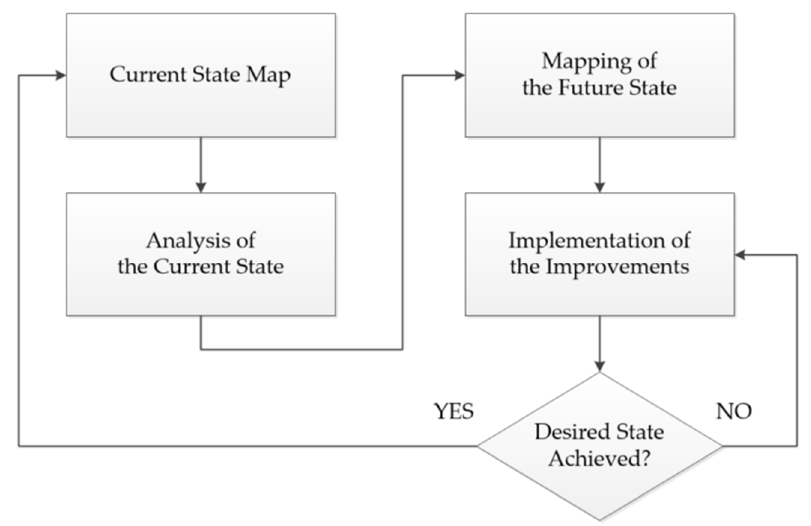
Figure 1. Value Stream Mapping process.